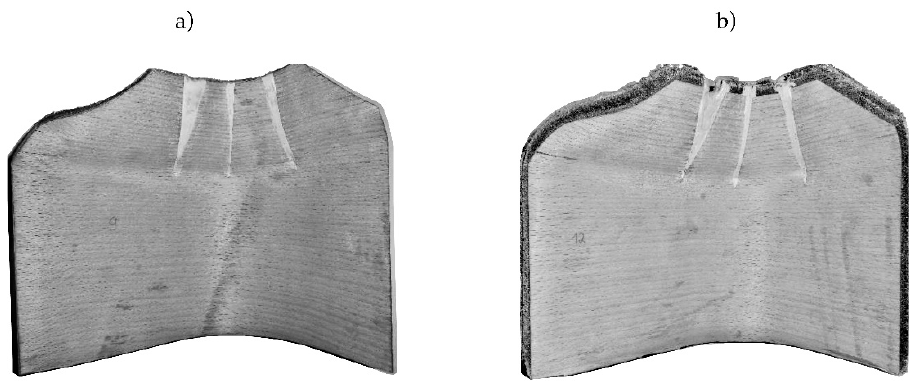
Figure 4. Relief cut of specimens ( a ) reference, ( b ) with flax fiber reinforcement.